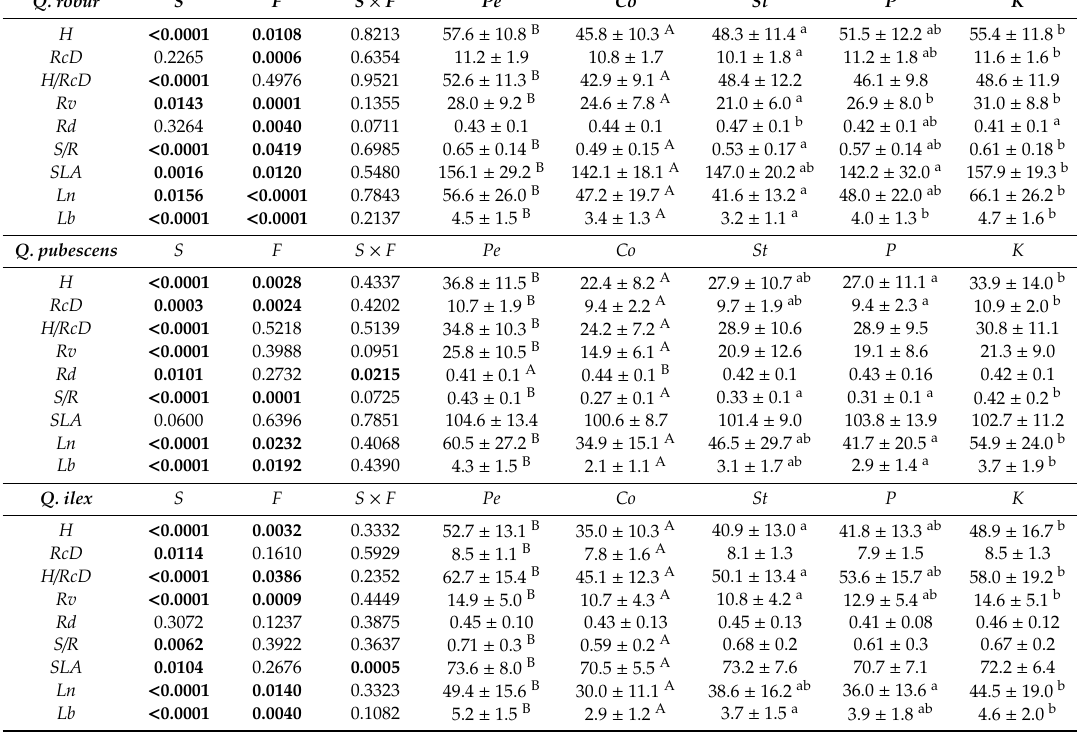
Table 2. Multifactorial ANOVA and Tukey post-hoc test results ( p ≤ 0.05 in bold) for seedling morphological traits (mean ± SD) at the end of the season (N obs = 20 seedlings per stocktype per species). Source of variation—substrate ( S ), fertilization ( F ), and their interaction ( S × F ). Capital and lowercase letters indicate homogeneous groups for S and F , respectively. Variables: H (height); RcD (root collar diameter in mm); H / RcD (seedling taper); Rv (root-system volume in cm 3 ); Rd (root-system density = Rb / Rv in g cm − 3 ); S / R (shoot–root ratio); SLA (specific leaf area, in cm 2 g − 1 ); Ln (number of leaves); and Lb (leaf dry biomass in